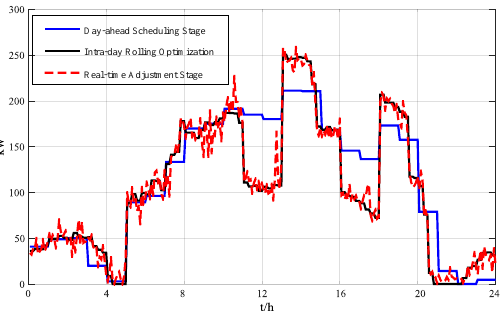
Figure 10. Refrigeration power of the adsorption refrigerator at multiple time scales.